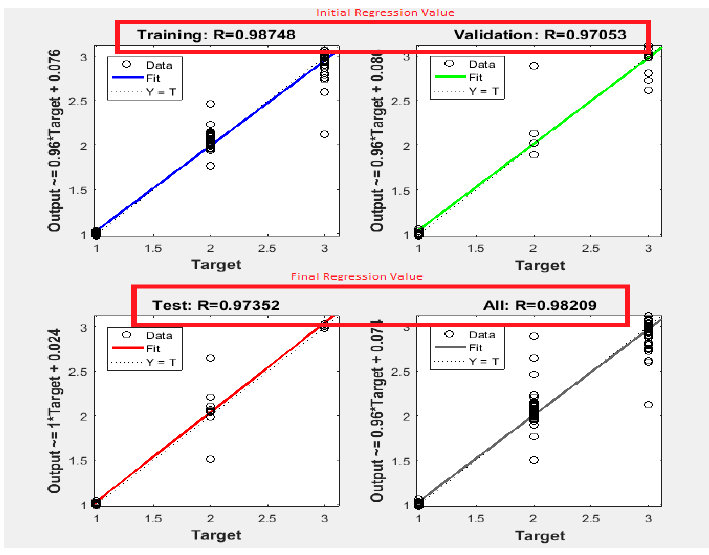
Figure 9. Regression model.